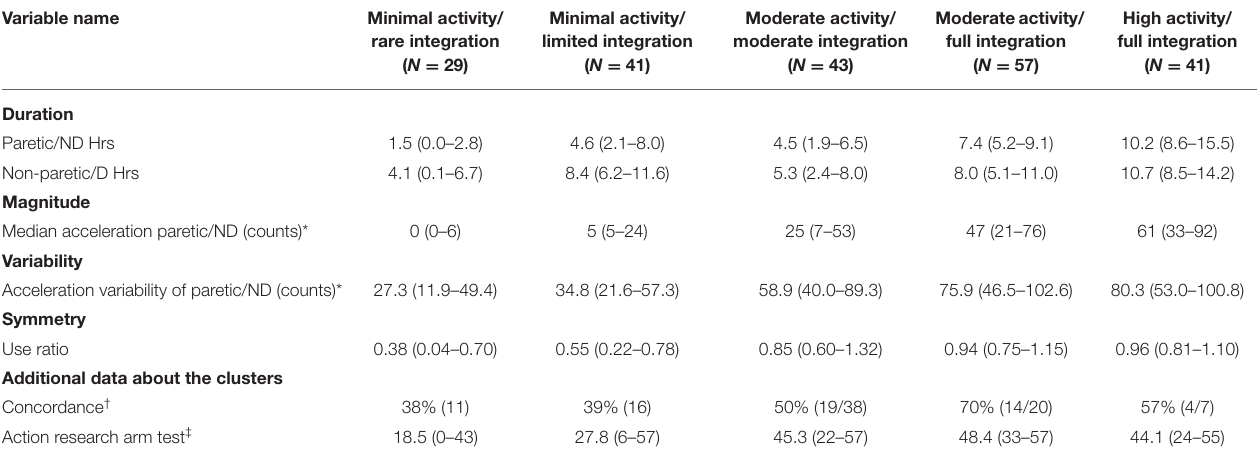
TABLE 4 | Means (ranges) of UL performance and capacity variables by